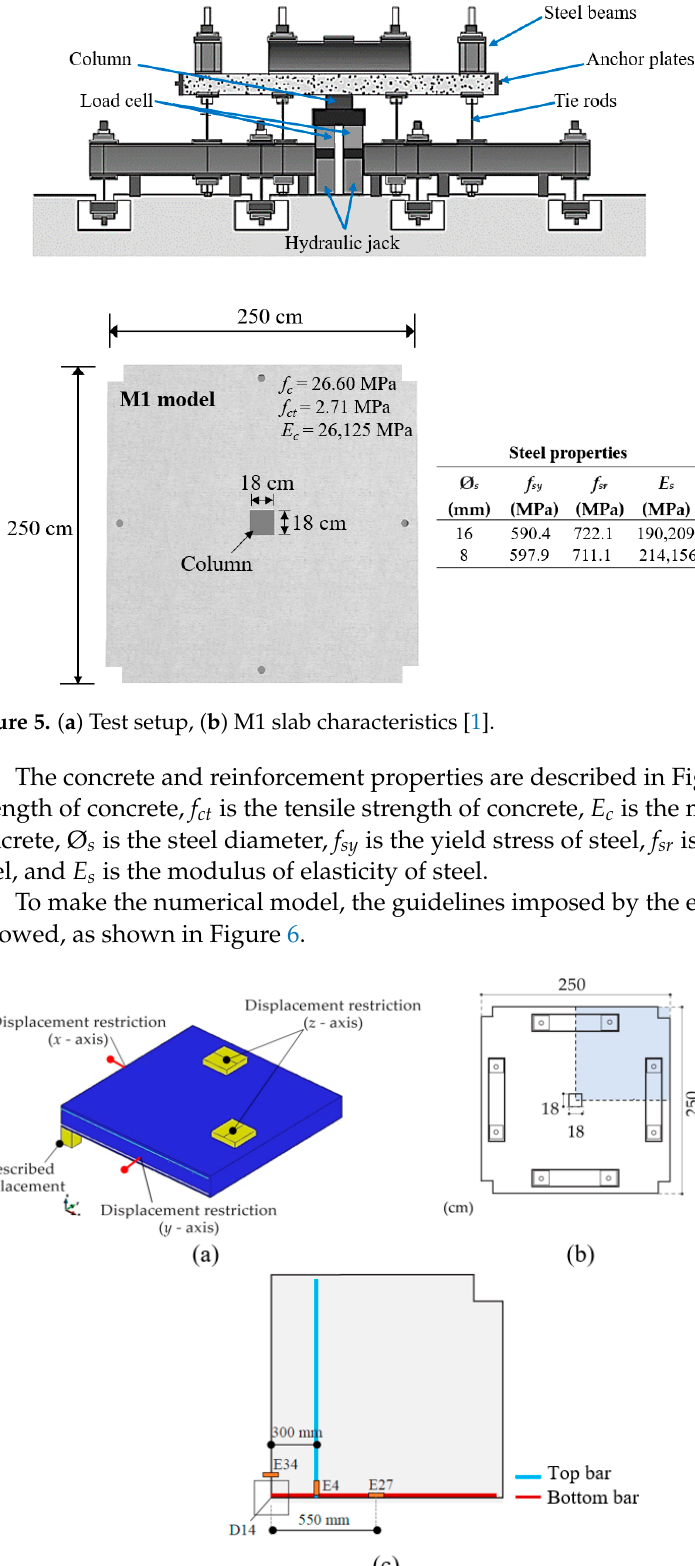
Figure 7. Comparison of numerical and experimental results of the M1 model.